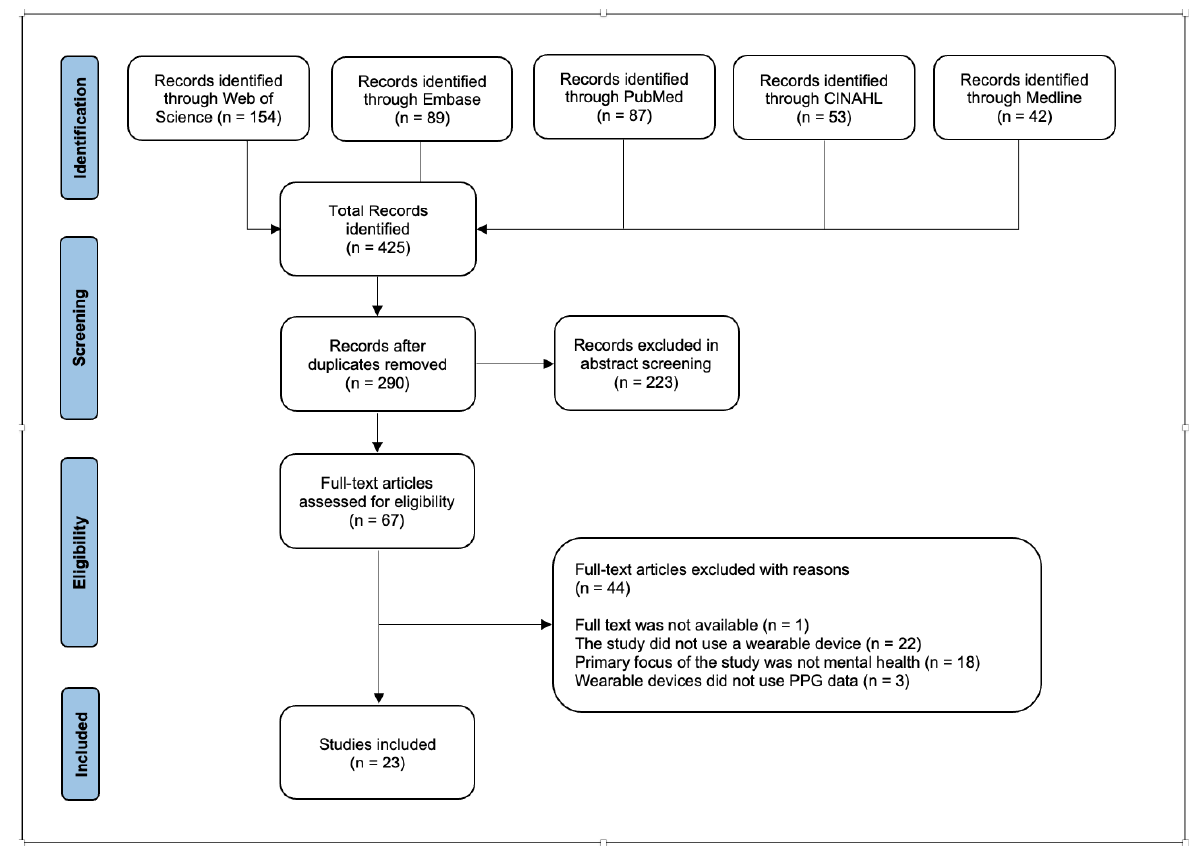
Figure 1. PRISMA flowchart of the identification and selection of studies. Table 2. Basic characteristics of the studies analyzed. The table summarizes the study type, sample size, and average age and the medical condition of the